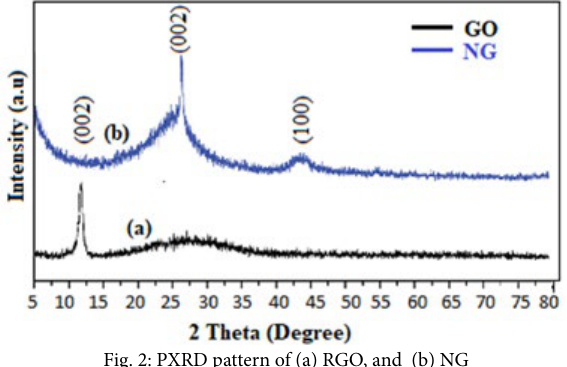
Fig. 2: PXRD pattern of (a) RGO, and (b) NG Fig. 2 PXRD pattern of (a) RGO, and (b) NG